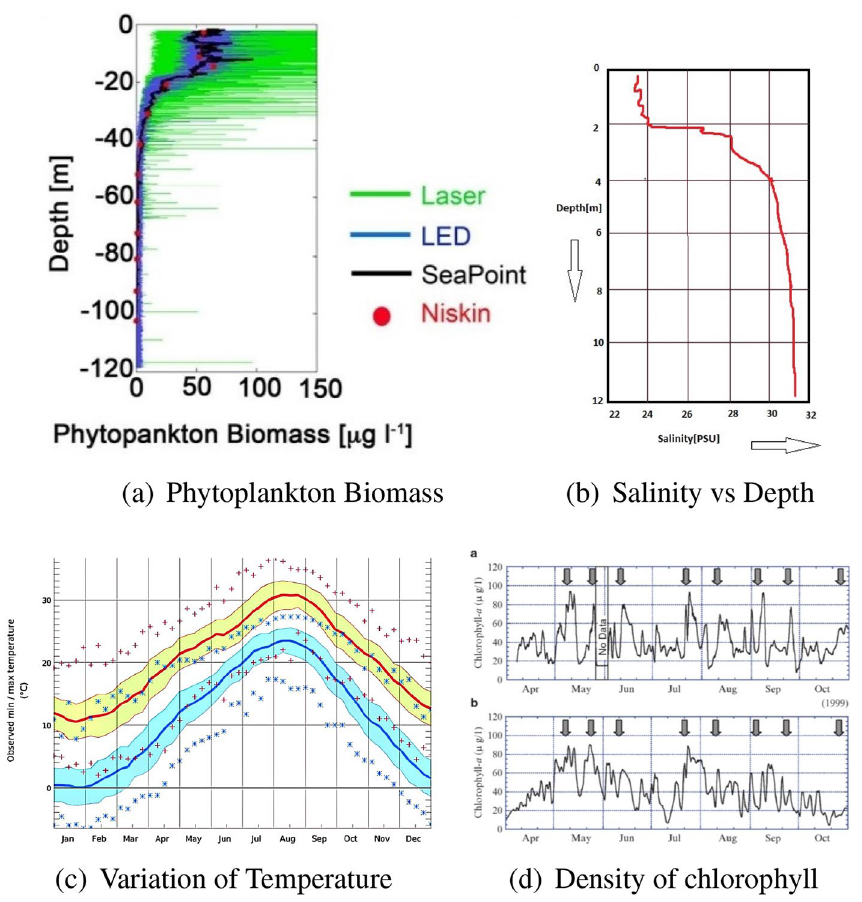
Figure 3. ( a ) Plot of data at different depths at the mouth of Tokyo Bay(region 1) on June 18, 2011 22 . ( b ) Salinity observed on 19th May 2011 at the mouth of Arakawa river (collected from 47 ). ( c ) Variation of temperature with seasons according to observed data near the mouth of Arakawa river (collectecd from 48